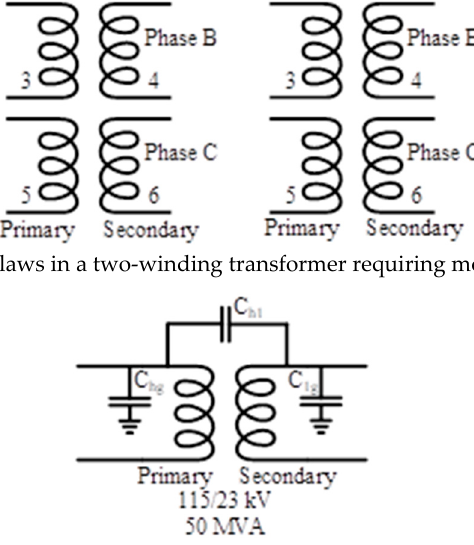
Figure 3. The winding of three-phase transformer faults. The transformer, as shown in Figure 2, is a step-down transformer that connects two sub-transmission sections. The transformer simulation is carried out by altering the system parameter condition as follows: the angles of the voltage waveform in phase A at the instants of fault inception were 0–330° (in 30° steps). The fault positions of the internal winding faults in ( a ) are designated on any phase of the transformer windings (both primary and secondary) at lengths of 10%, 20%, 30%, 40%, 50%, 60%, 70%, 80%, and 90%, measured from the line end of the windings. For the inter-turn faults, the position of point a on the transformer winding, as shown in ( b ), was varied at the length of 10%, 20%, 30%, 40%, 50%, 60%, 70%, and 80%, measured from the line end of the windings. For the inter-turn faults, the position of point b on the transformer winding, as shown in ( b ), was varied at the length of 10%, 20%, 30%, 40%, 50%, 60%, 70%, and 80% measured from the line end of the windings. The phase winding of the transformer with internal faults is separated into two portions in the event of winding to ground faults and three parts in the case of inter-turn faults, as shown in ( b ). ( c ) The capacitances are as follows: the stray capacitance between the high voltage winding and ground is C hg , the stray capacitance between the low voltage winding and ground is C lg , and the stray capacitance between the high voltage and low voltage winding is C hl .